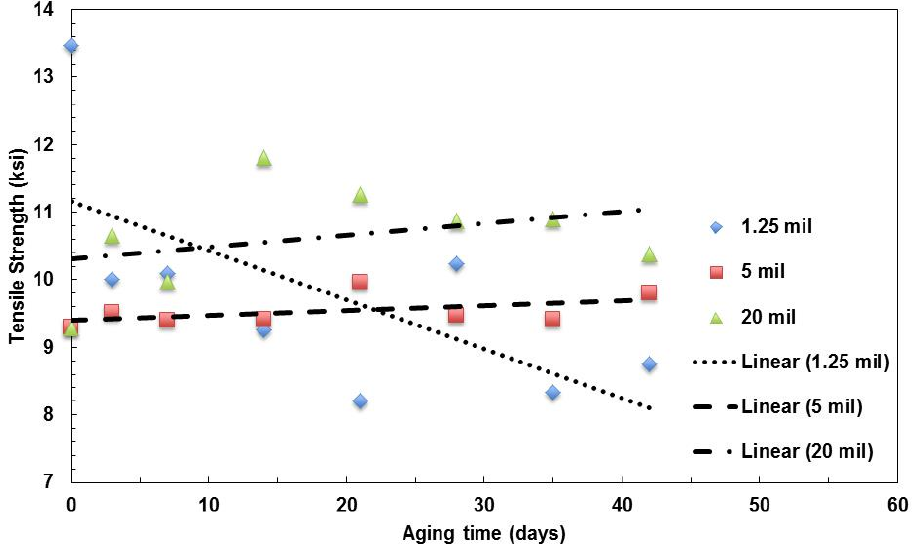
Figure 6. Summary of the change in tensile strength with aging time for films with various film thicknesses aged at 100